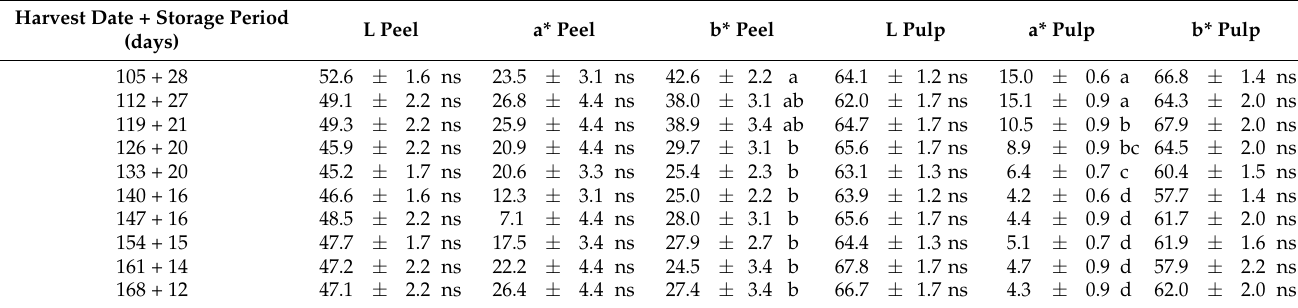
The values followed by different letters in the same column indicate significant differences ( p ≤ 0.05). Table 4. Peel and pulp color of Osteen mango (mean ± SD, n = 12) at consumption point after storage period at 20 ◦ C and 70% RH (harvest date + shelf life). L indicates the color’s brightness, a* its position between red/magenta and green and b* its position between yellow and